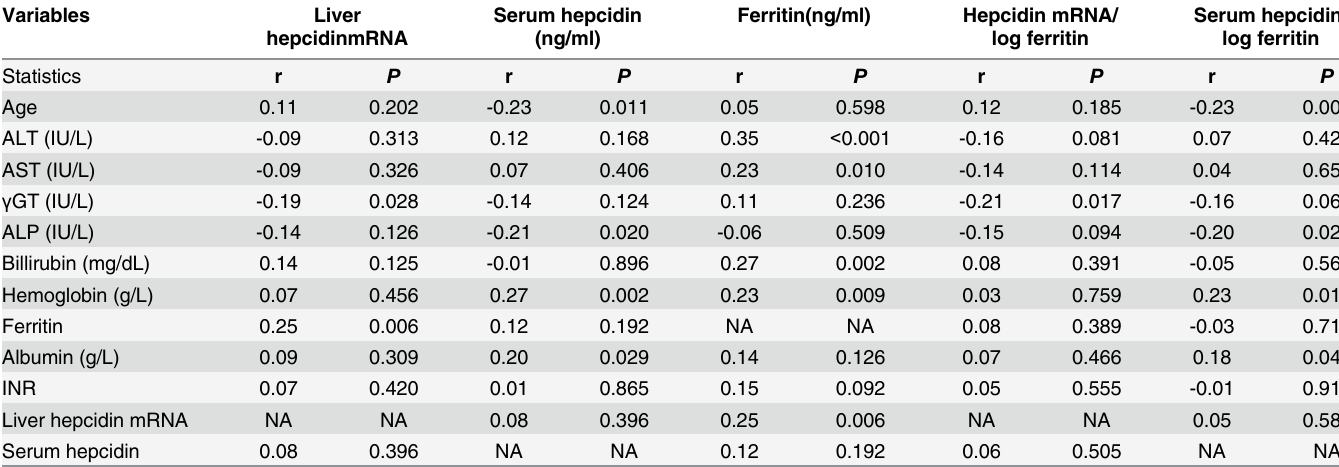
Table 2. Correlations between liver hepcidin mRNA, serum hepcidin, ferritin and clinical characteristics of patients. Variables